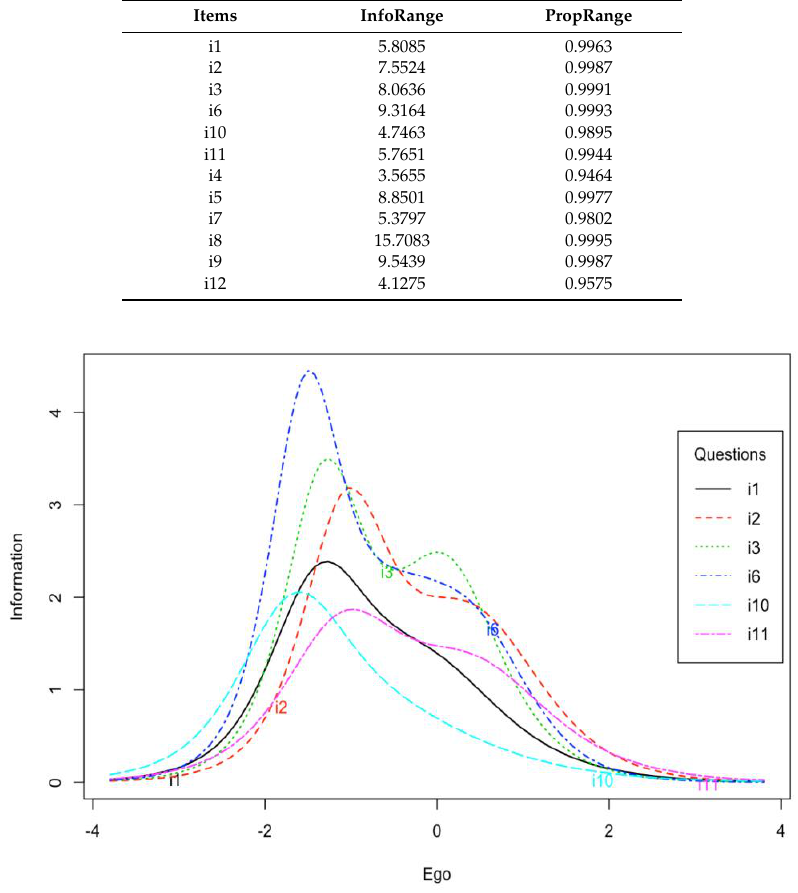
Figure 1. Information curves for the POSQ ego subscale items. Int. J. Environ. Res. Public Health 2020 , 17 , x FOR PEER REVIEW